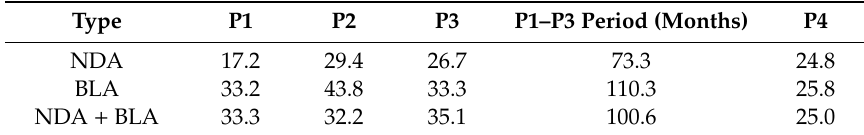
Table 8. Development period (month) of new drugs in each phase for the whole period (1970–2017).